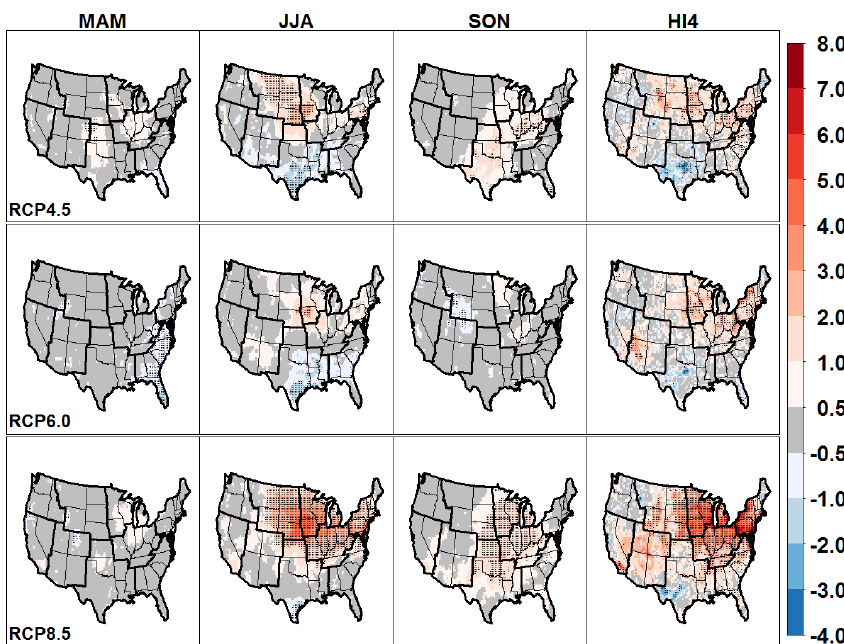
Figure 4. Projected changes in maximum daily 8h average (MDA8) O 3 mixing ratios (ppb) from 1995–2005 to 2025–2035 under RCP4.5, RCP6.0, and RCP8.5 (in rows). Columns show projected changes for spring, summer, and autumn seasonal means, as well as fourth-highest annual values (“HI4”). Dark pixels indicate where differences are significant according to Student’s t test ( p < 0 . 05).